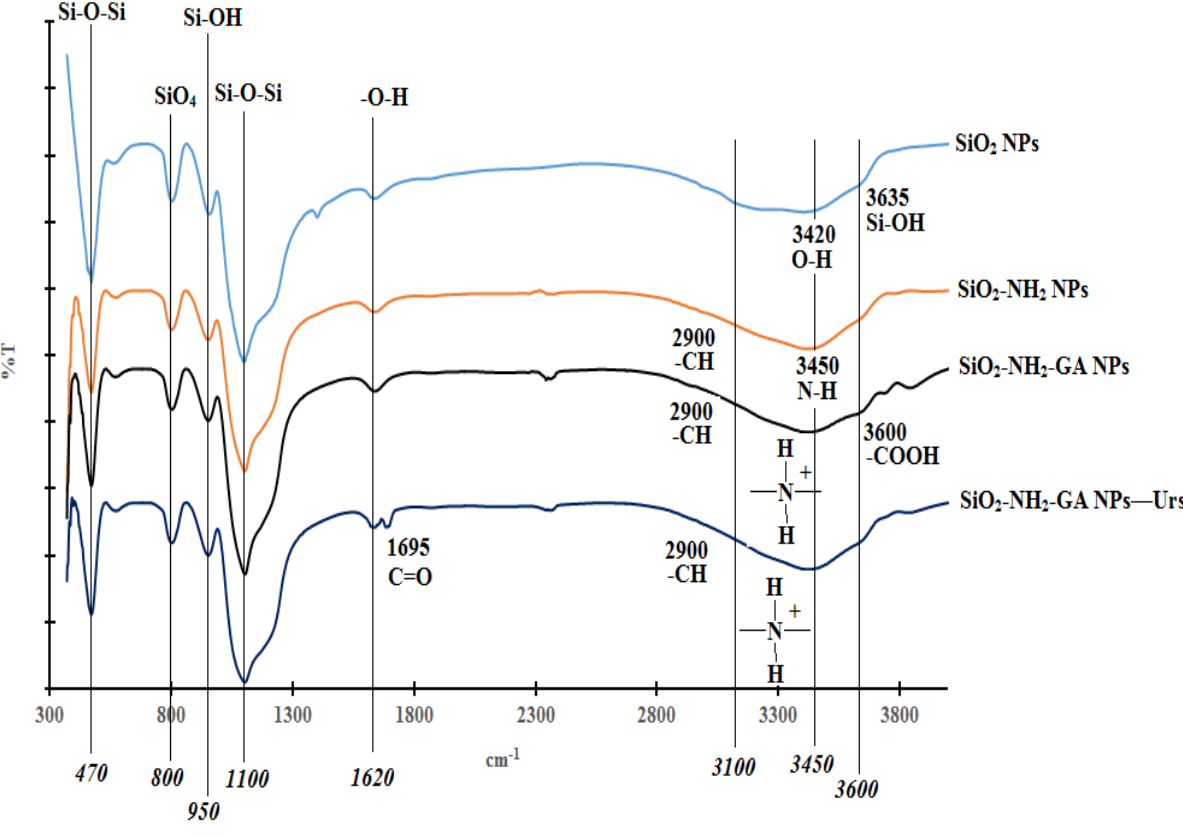
Figure 4. The FTIR spectra for SiO and SiO NPs-NH 2